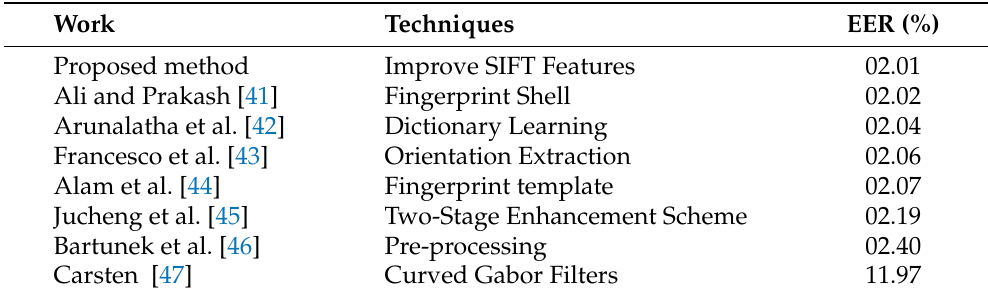
Figure 11. A plot of the ROC curve between FMR and FNMR for the FVC 2004 fingerprint database. A comparison of the matching performance in terms of EER (%) between the proposed framework and some closely related works is presented in Table 1. Table 1. A summary of the performance comparison between the proposed framework and most closely related